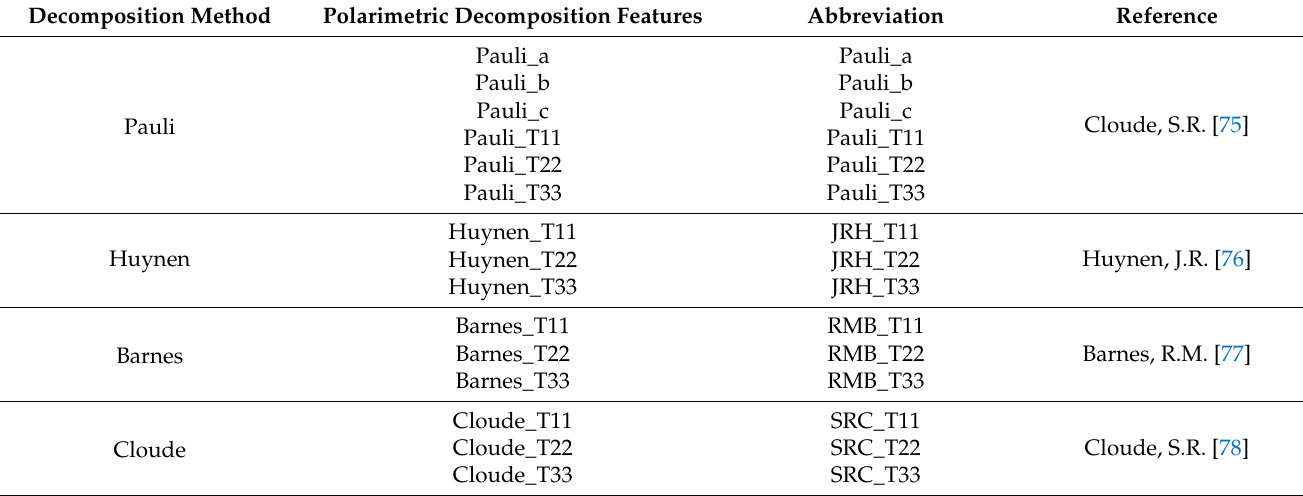
Table 1. List of the polarimetric decomposition features extracted from the Radarsat-2 image using 10 decomposition